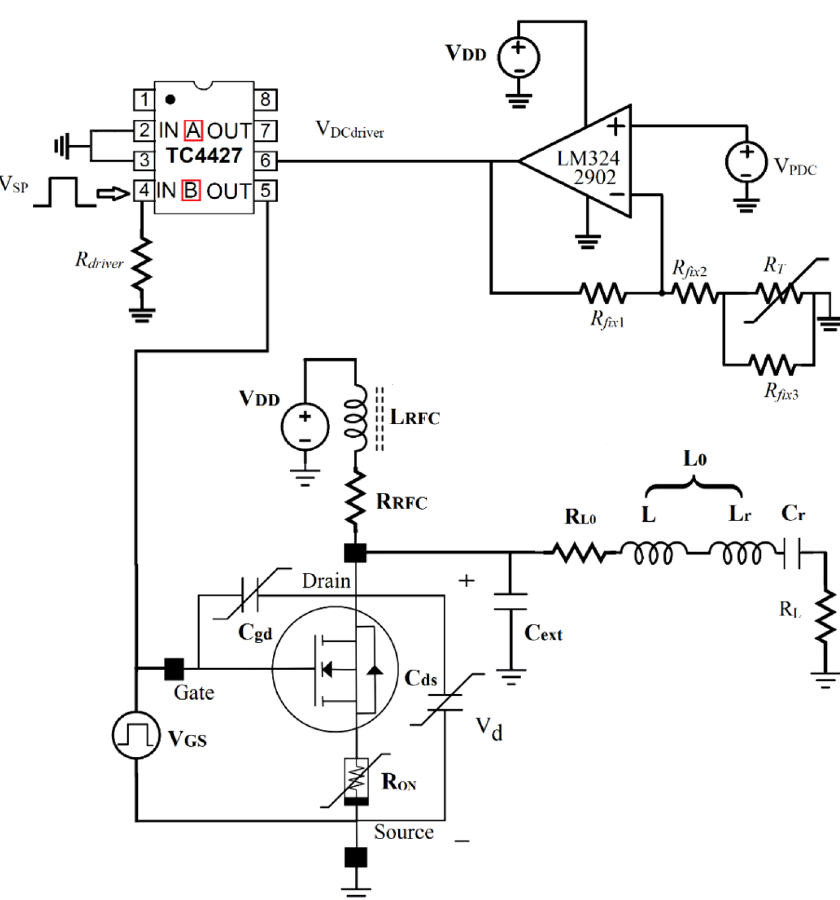
Figure 17. The equivalent circuit of the thermal compensated class E (TCCE)